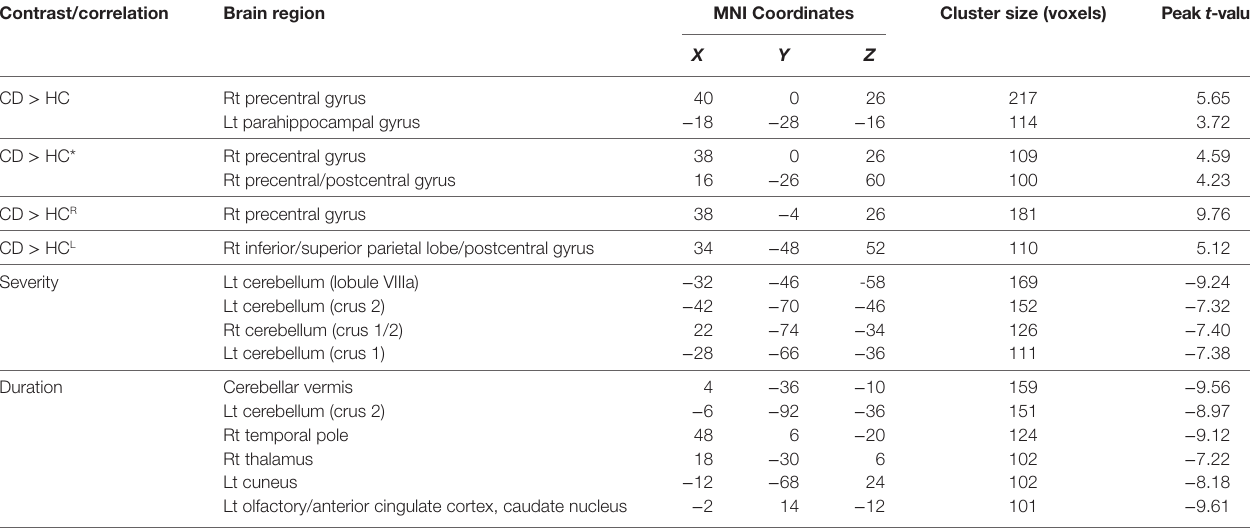
TaBle 2 | Anatomical localization of significant clusters identified in the voxel-based analyses. contrast/correlation Brain